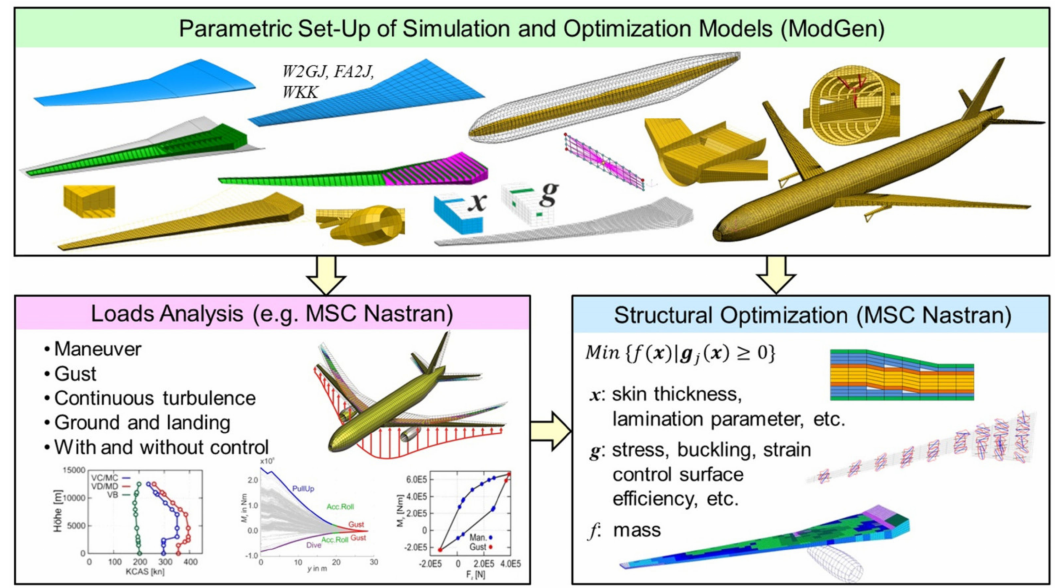
Figure 4. The basic MONA